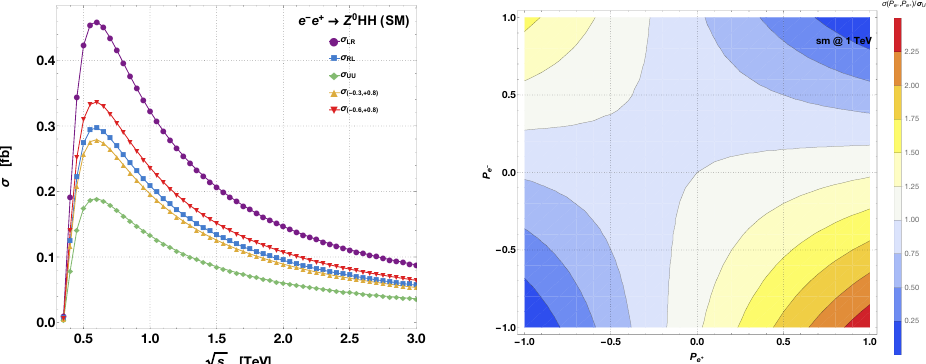
Figure 4 . (Left): the distributions of the cross section for various polarizations of the incoming e (cid:0) e + beams. (Right): the ratio of the cross sections ( (cid:27) ( P e (cid:0) ; P e + ) =(cid:27) UU ) as a function of the polarization of the incoming electron/positron